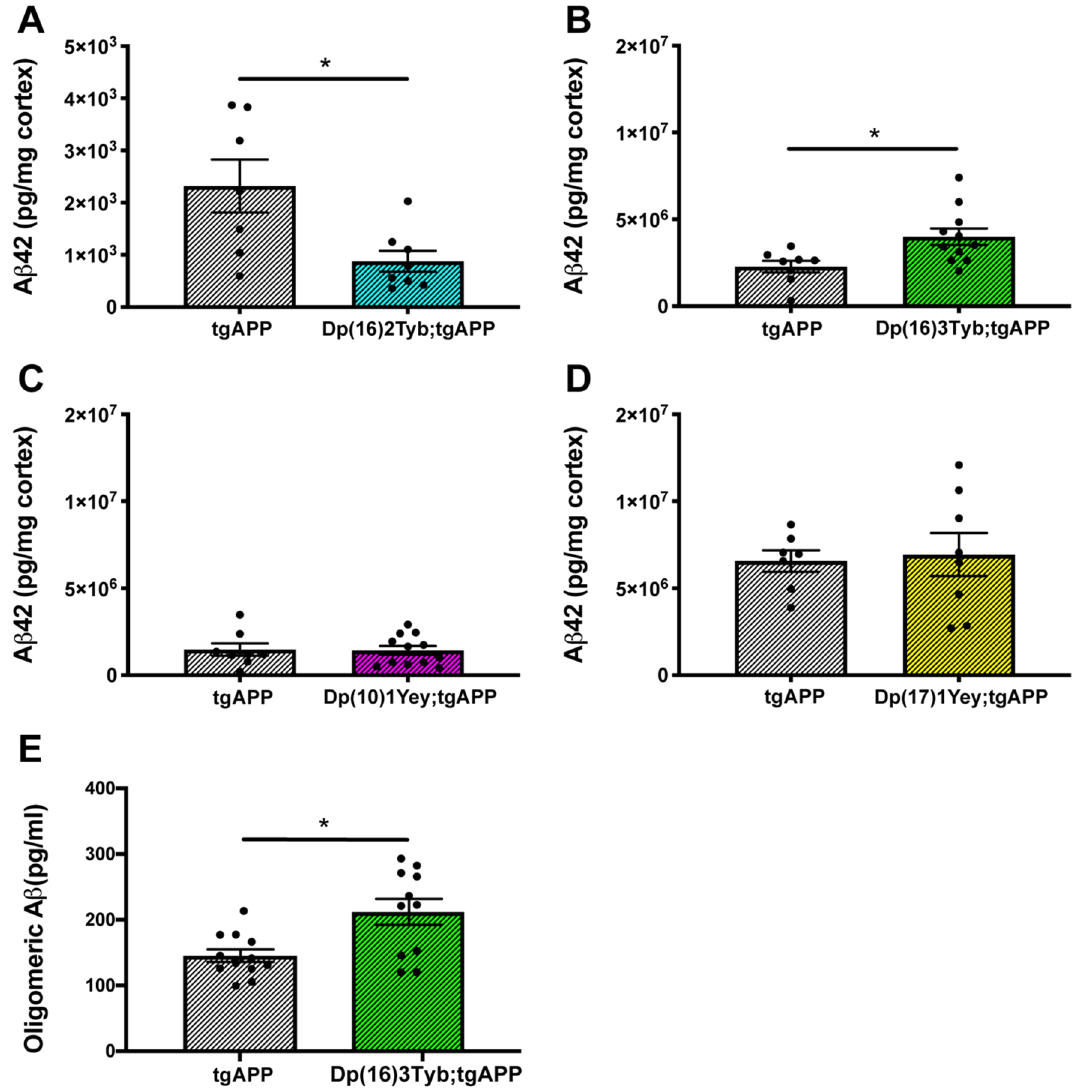
Figure 4. The effect of DS segmental duplication models on insoluble amyloid-β 42 in the cortex. ( A – D ) Cortical proteins from 6- and 12-month old mice were fractionated and 5 M guanidine hydrochloride, soluble Aβ was quantified by Meso Scale Discovery Assay. Error bars show SEM, data points are independent mice. ( A ) In Dp(16)2Tyb;tgAPP (n = 8, 3 male and 5 female) mice at 6 months of age, median amyloid-β 42 abundance is significantly decreased (U(N Dp(16)2Tyb;tgAPP = 8, N tgAPP = 7,) = 8, p = 0.021) in cortex compared to tgAPP (n = 7, 2 male and 5 female) littermates. After systematic outlier testing one tgAPP sample was excluded prior to analysis. ( B ) In Dp(16)3Tyb;tgAPP (n = 11, 7 male and 4 female) mice at 12 months of age, amyloid-β 42 abundance is significantly increased (F(1,13) = 4.656, p = 0.05) compared to tgAPP (n = 8, 5 male and 3 female) littermates. After systematic outlier testing two tgAPP samples were excluded prior to analysis. ( C ) In Dp(10)1Yey;tgAPP (n = 12, 6 male and 6 female) mice at 12 months of age, amyloid-β 42 abundance (F(1,14) = 0.027, p = 0.872) did not significantly differ compared to tgAPP (n = 8, 5 male and 3 female) littermates. After systematic outlier testing one tgAPP sample and two Dp(10)1Yey;tgAPP samples were excluded prior to analysis. ( D ) In Dp(17)1Yey;tgAPP (n = 8, 3 male and 5 female) mice at 12 months of age, amyloid-β 42 abundance (F(1,9) = 2.115 p = 0.176) did not significantly differ compared to tgAPP (n = 7, 4 male and 3 female) littermates. After systematic outlier testing two tgAPP samples and one Dp(17)1Yey;tgAPP sample were excluded prior to analysis. ( E ) In Dp(16)3Tyb;tgAPP (n = 11, 6 male and 5 female) mice at 3 months of age, median oligomeric Aβ species were significantly increased U(N Dp(16)3Tyb;tgAPP = 11, N tgAPP = 12,) = 104, p = 0.019) compared to tgAPP (n = 12, 8 male and 4 female)